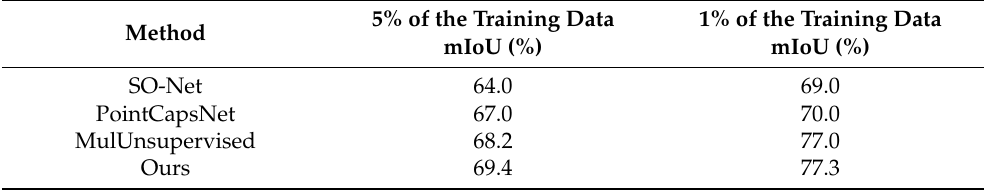
Table 3. Part segmentation performance results on 1% and 5% of the training data.